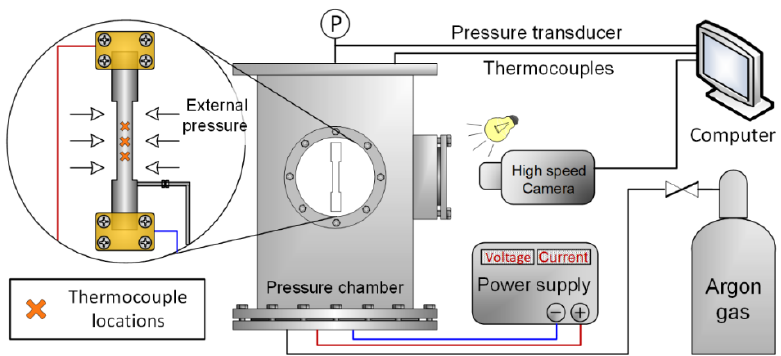
Figure 1. Schematic of the experimental setup.